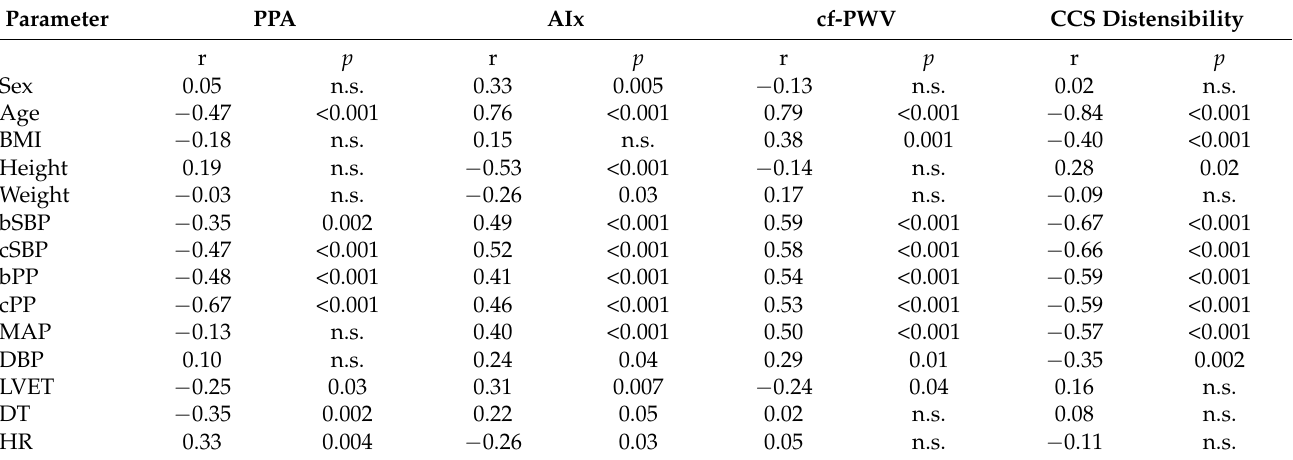
Table 2. Bivariate analysis (Spearman’s correlation coefficient) between the main parameters for estimating arterial stiffness and clinical and anthropometric